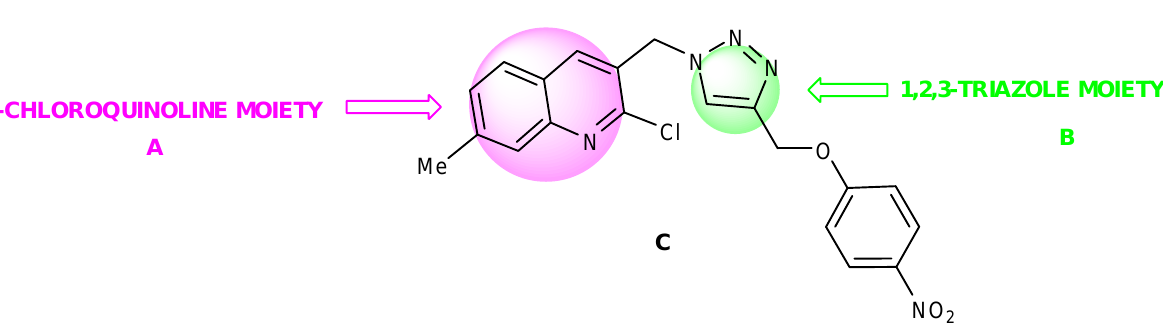
Scheme 1. Design of hybrid